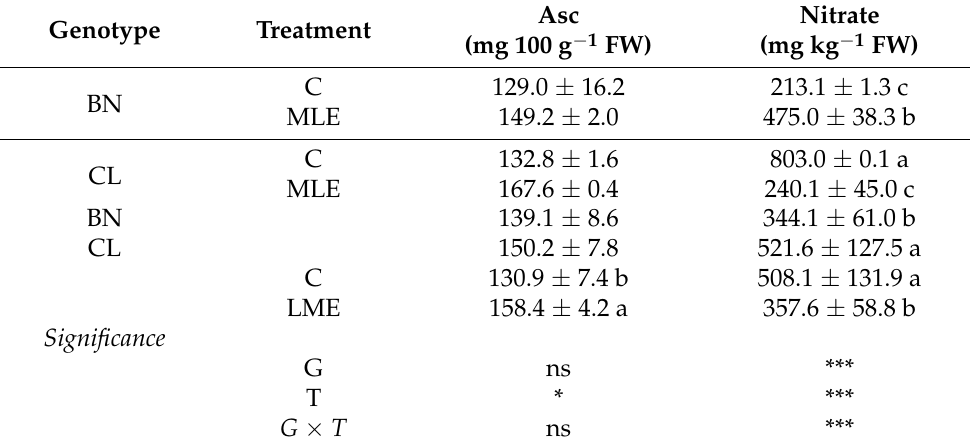
Table 6. Effect of MLE application on ascorbic acid, Asc (mg g − 1 FW) and Total nitrate (mg kg − 1 FW) on plant of BN and CL. Extract was sprayed 15, 30 and 43 days after sowing.